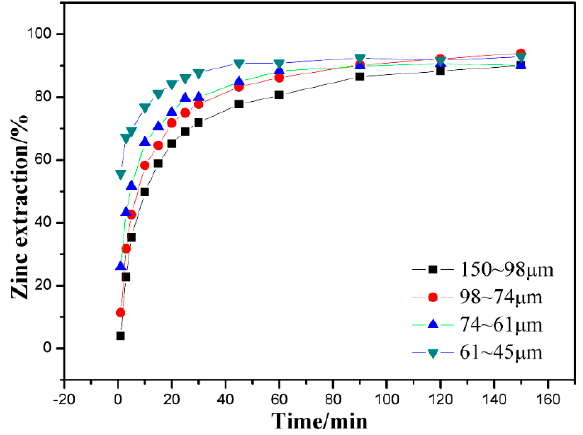
Figure 6. Effect of particle size on zinc extraction (5.0 mol/L NH 4 Cl; solid/liquid ratio, 5 g/L; stirring speed, 350 rpm; and temperature, 95 °C).